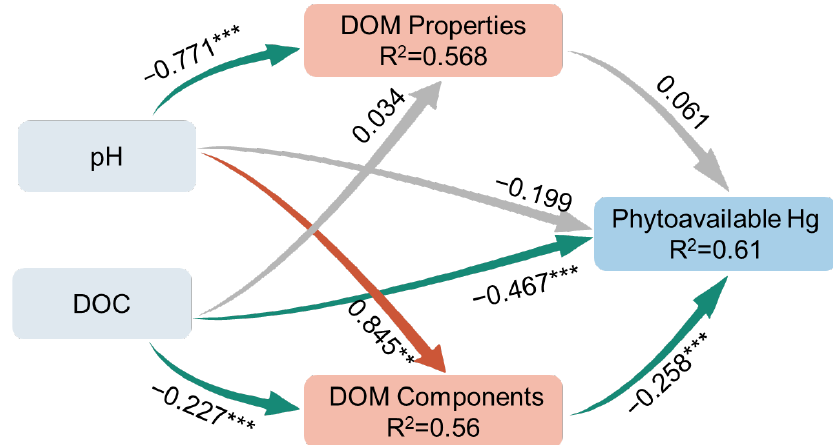
Figure 6. PLS-PM analysis of relationships between soil pH and DOC, DOM characteristics (components and properties), and phytoavailable Hg contents in soil. The red, green and gray lines with arrows represent significant positive, significant negative and nonsignificant correlations, respectively. Numbers labeled adjacent to the arrow represent the path coefficients. R 2 is the amount of interpretation of the variable. Significance is presented by * p < 0.05, ** p < 0.01, and *** p < 0.001.